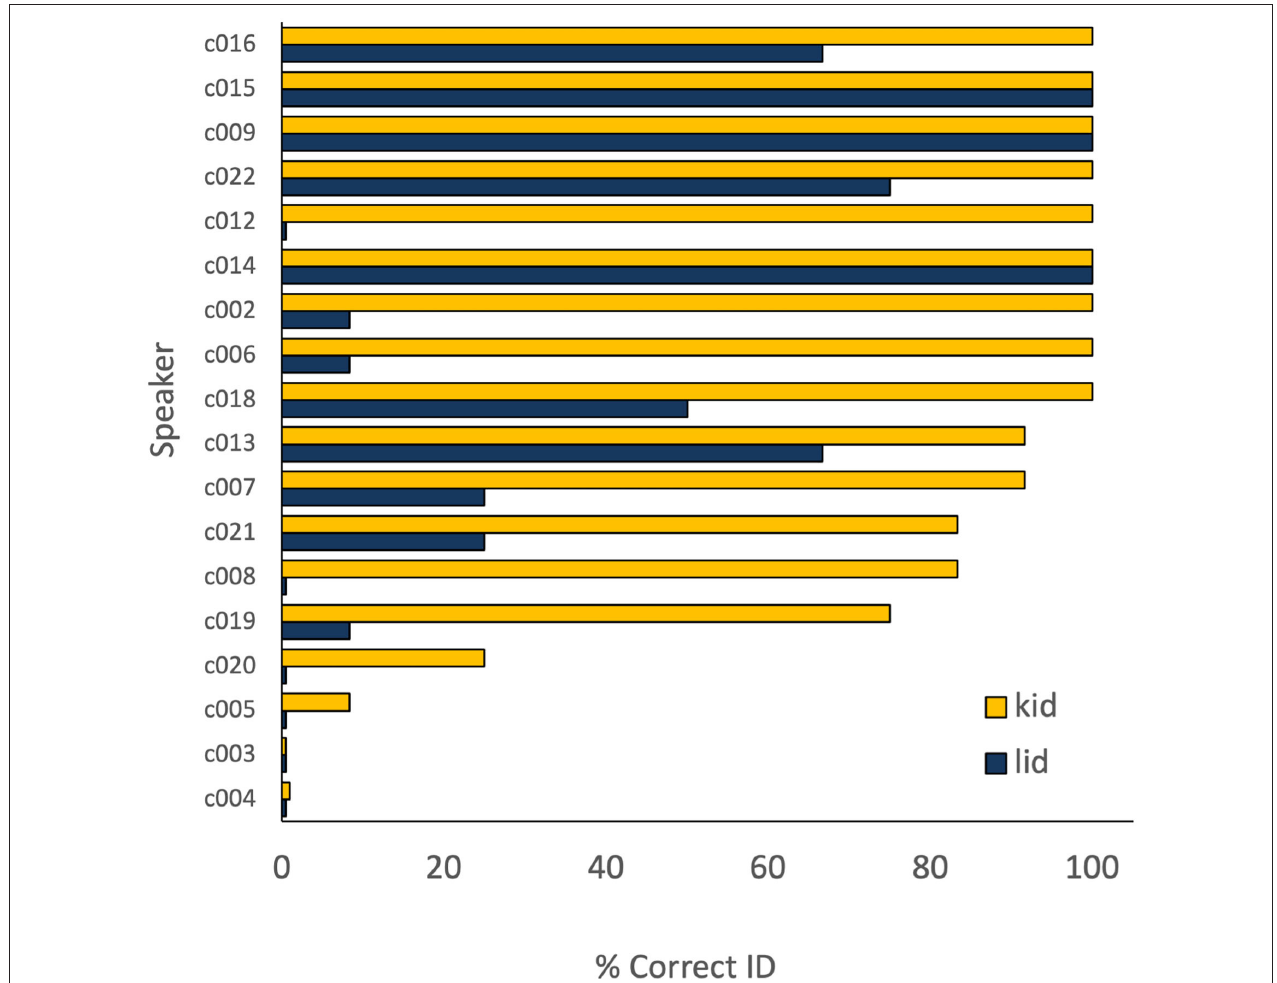
FIGURE 1 | Individual speaker performance (% intelligibility) on kid and lid .